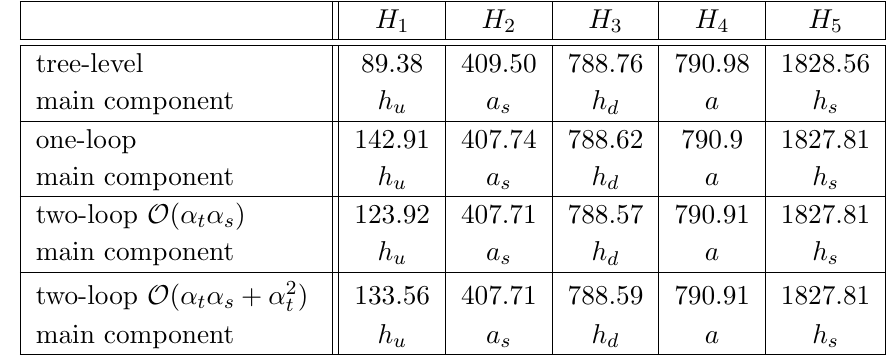
Table 5 . P2DR: mass values in GeV and main components of the neutral Higgs bosons at tree- level, one-loop, two-loop O ( (cid:11) t (cid:11) s ) and at two-loop O ( (cid:11) t (cid:11) s + (cid:11) 2 in the top/stop